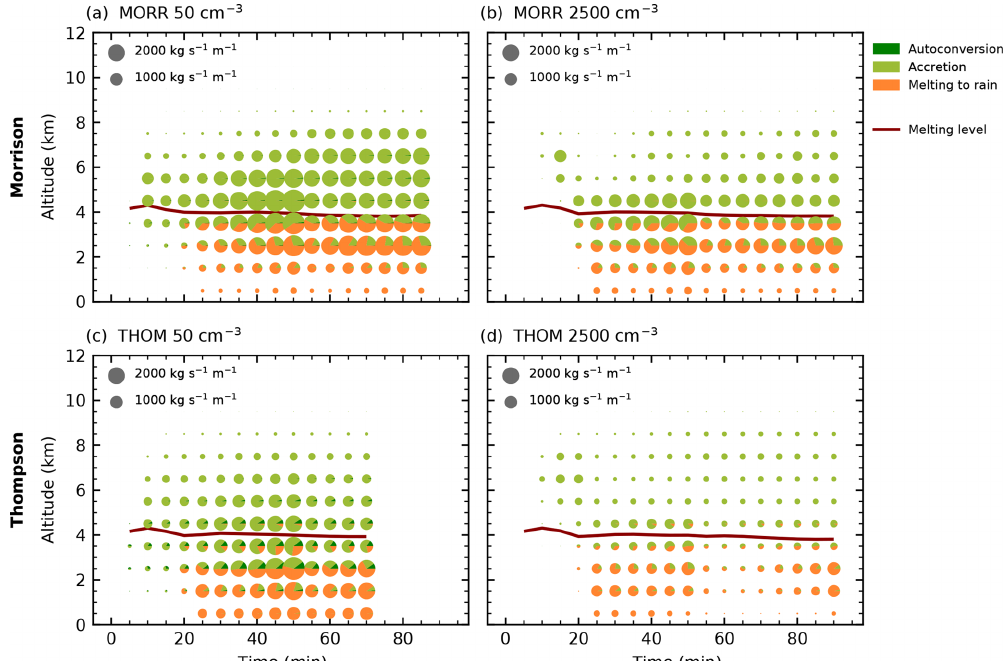
Figure 7. Time evolution of the microphysical process rates relevant for rain formation processes (autoconversion, accretion of cloud droplets by rain and melting of ice hydrometeors) as in Fig.